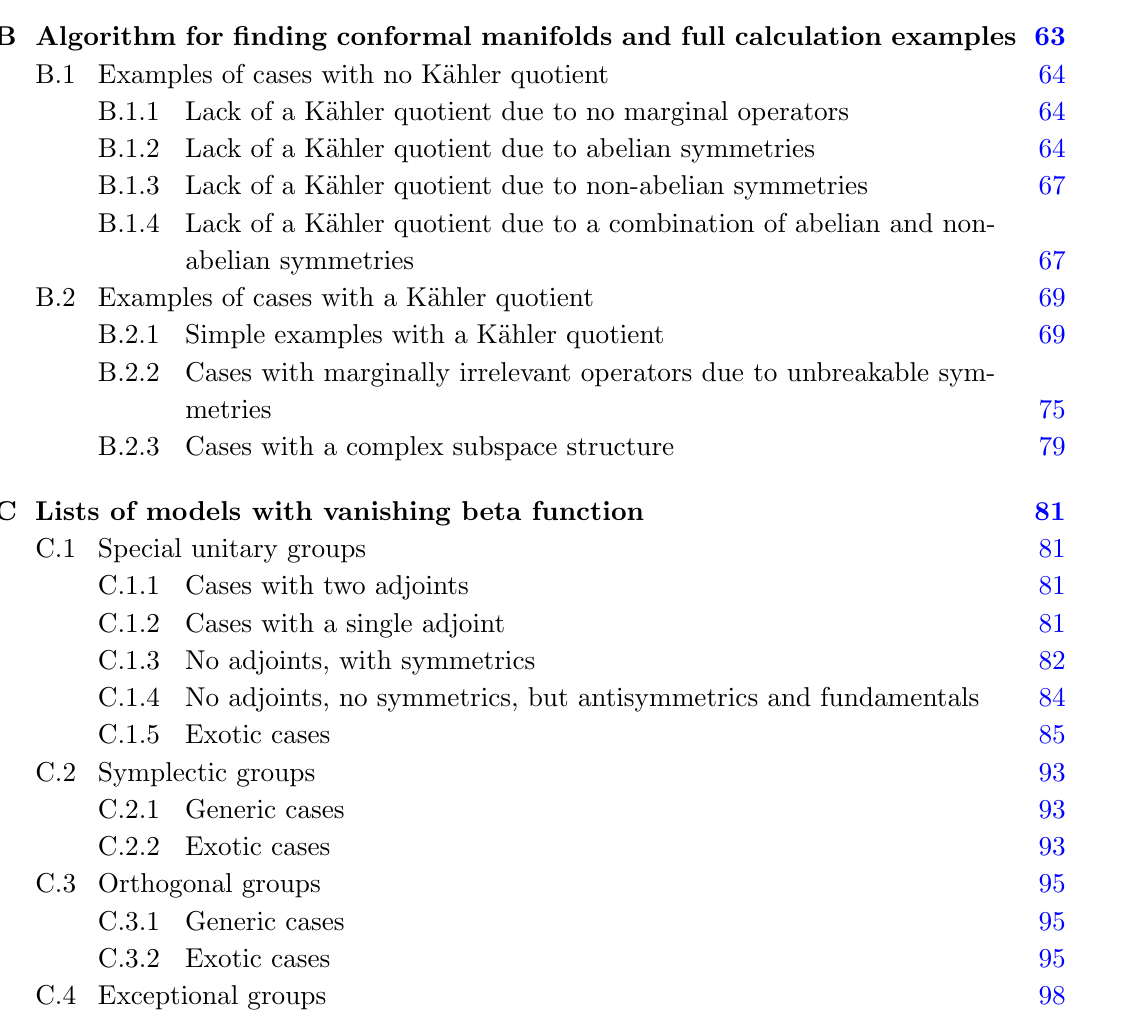
B Algorithm for (cid:12)nding conformal manifolds and full calculation examples